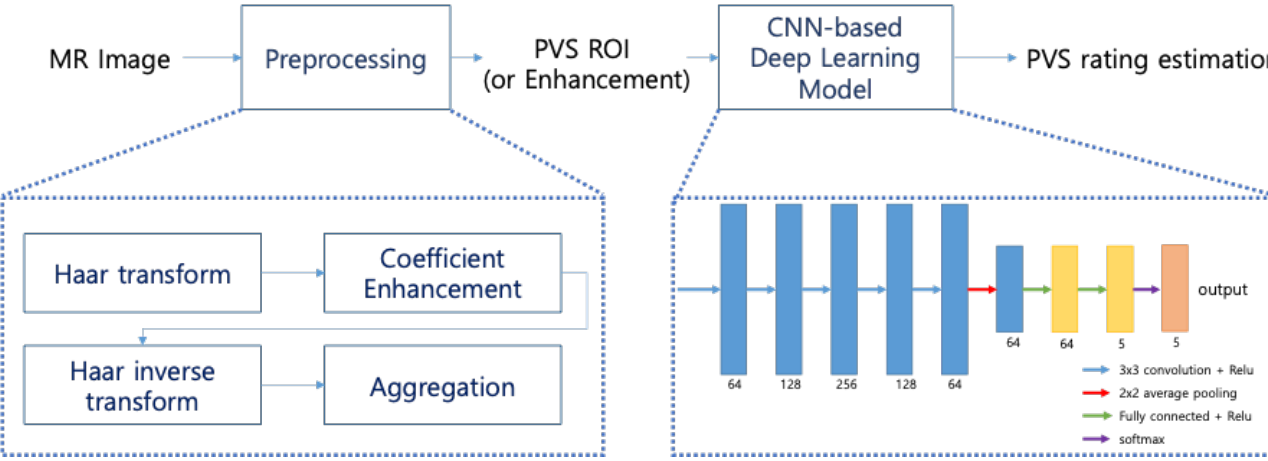
Figure 1. Proposed framework for direct rating estimation of EPVS. Each highlighted box represents the image pre-processing to enhance the EPVS region and the EPVS rating estimation model.